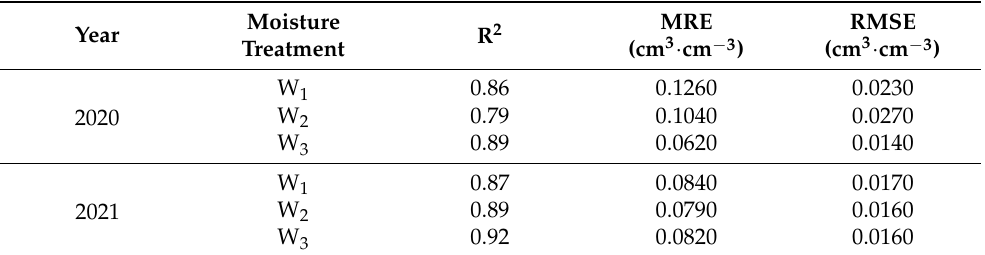
Table 1. Soil hydraulic parameters were predicted based on the Rosetta model built into the HYDRUS-2D model. Soil particle composition (clay, silt, sand, volume percentage) and initial bulk density were used to predict soil hydraulic parameters. The 0–60 cm soil layer was divided into three layers, and the average value of each layer was considered. The soil hydraulic parameters, after calibration, are shown in Table 2. Table 1. Statistical indicators to evaluate the accuracy of the HYDRUS-2D model in the estimation of soil water content (cm 3 · cm − 3 ) under different water